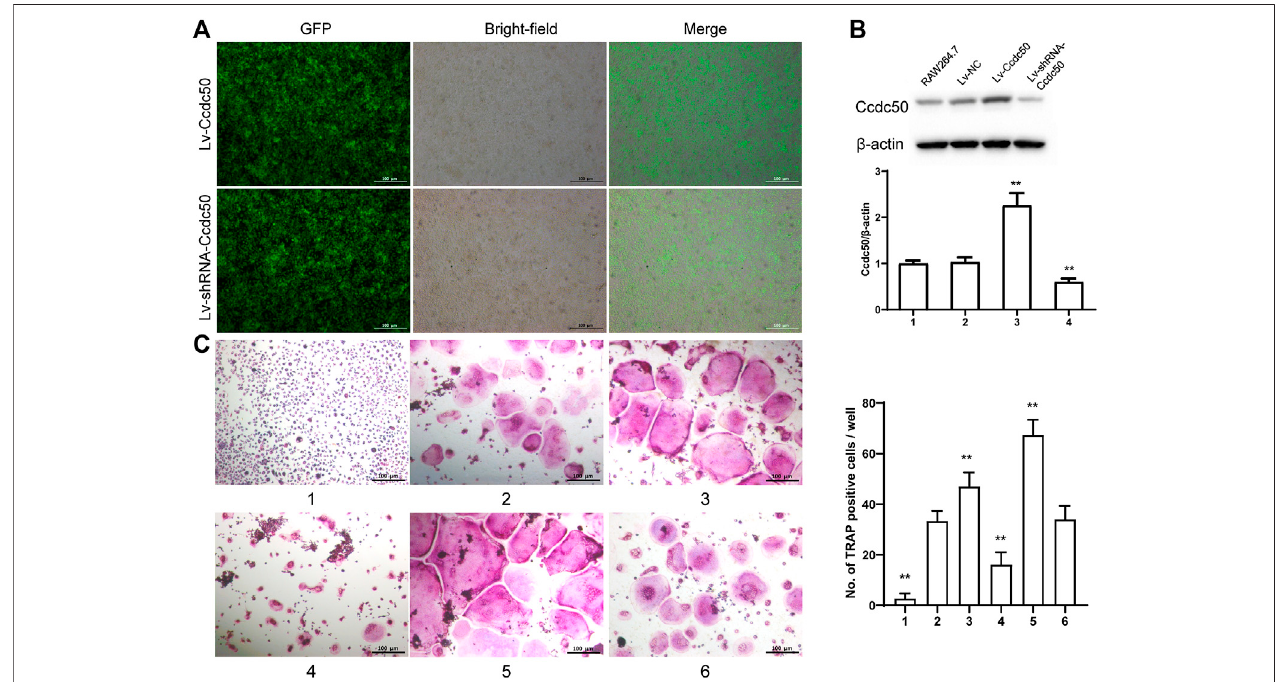
FIGURE 5 | Myostatinregulates osteoclastogenesisunder theregulationofCcdc50. (A) Thelocalization of Ccdc50 expressed by lentivirusafter 72 h was ascertained by fl uorescence staining. (B) The expression of Ccdc50 of four groups were detected by western blot. (C) Representative images and quantitative analysis of RAW264.7 cells cultured inthe sixgroupsand stainedfor TRAP.1) RAW264.7cells.2) RAW264.7cellsinfectedwith Lv-NC, induced with M-CSF, RANKL.3) RAW264.7cellsinfected with Lv- NC,inducedwithM-CSF,RANKL,and30 ng/mlmyostatin.4)RAW264.7cellsinfectedwithLv-Ccdc50,inducedwithM-CSF,RANKL.5)RAW264.7cellsinfectedwithLv- shRNA-Ccdc50, induced with M-CSF, RANKL, and 30 ng/ml myostatin; 6) RAW264.7 cells infected with Lv-Ccdc50, induced with M-CSF, RANKL, and 30 ng/ml myostatin.